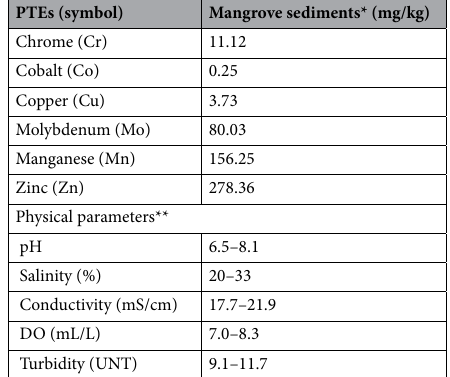
Table 1. Concentrations of potentially toxic elements in sediments and physicochemical properties of water in mangroves of Sepetiba Bay. *Data analyzed by ICP-OES refer to samples (n = 5) of up to 20 cm depth of sediment from Sepetiba Bay mangrove according to Flores et al. 12 . ** Silva 13